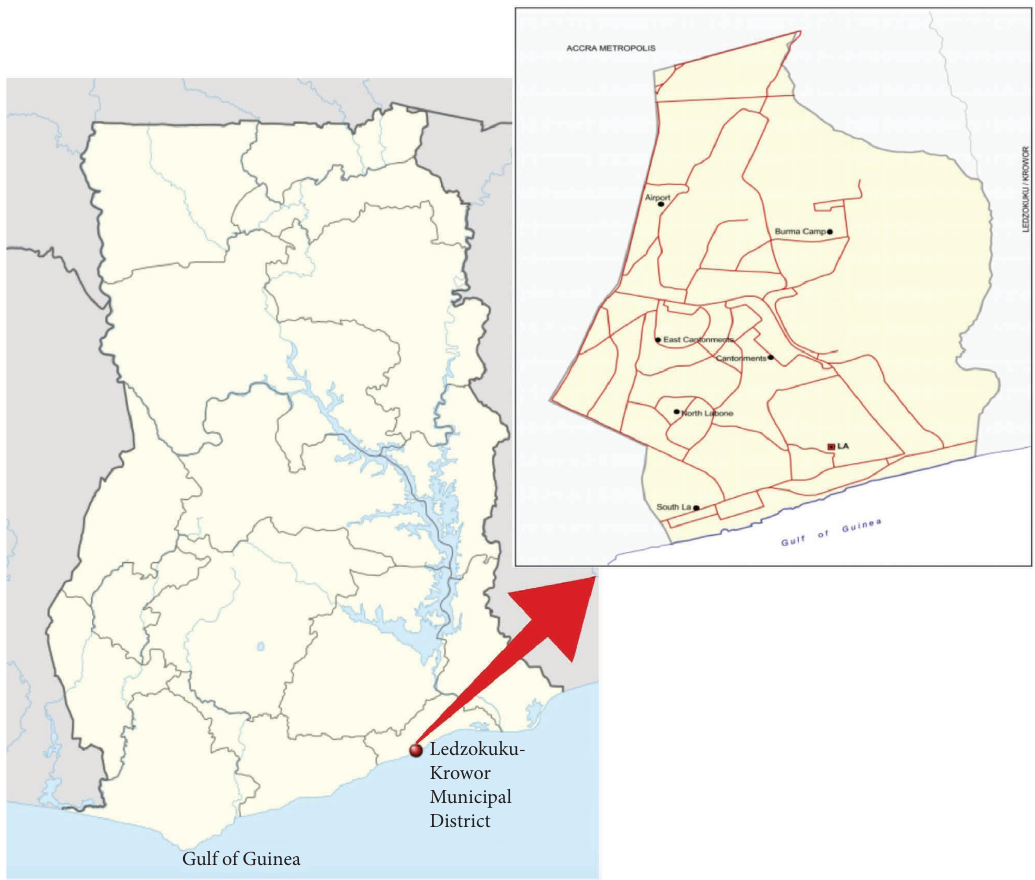
Figure 1: Map of Ghana and communities in the Krowor municipality (by nordnordwest and manny 9455 licensed under CC BY-SA 3.0 and